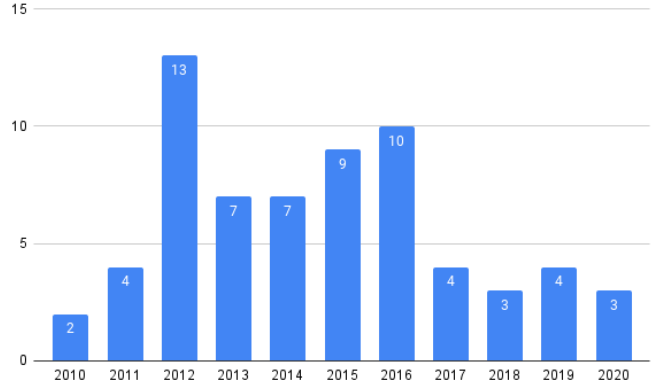
Figure 19. Number of papers published by year.